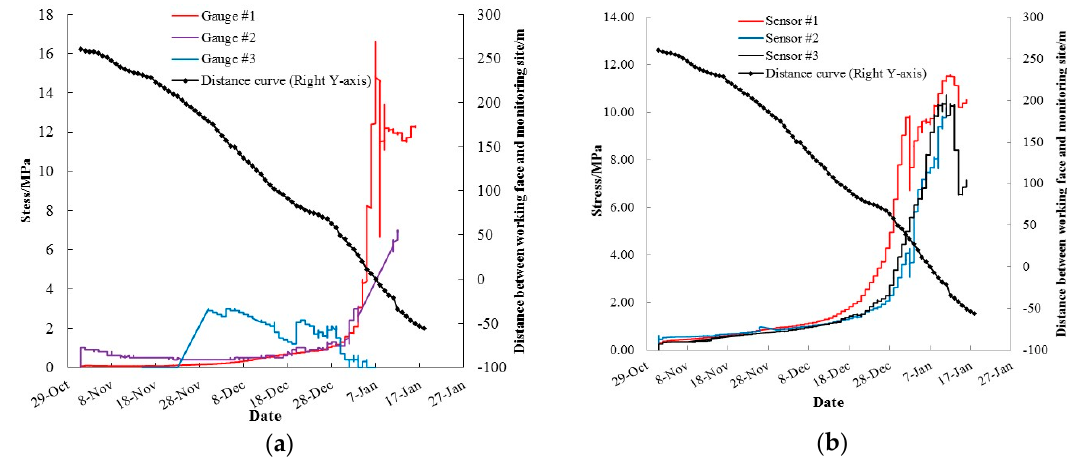
Figure 18. Monitoring results of normal stress loading on roof bolts during the approaching of the 1111(1) longwall face: ( a ) Electric pressure gauges; ( b ) FBG stress sensors. 1111(1) longwall face: ( a ) Electric pressure gauges; ( b ) FBG stress